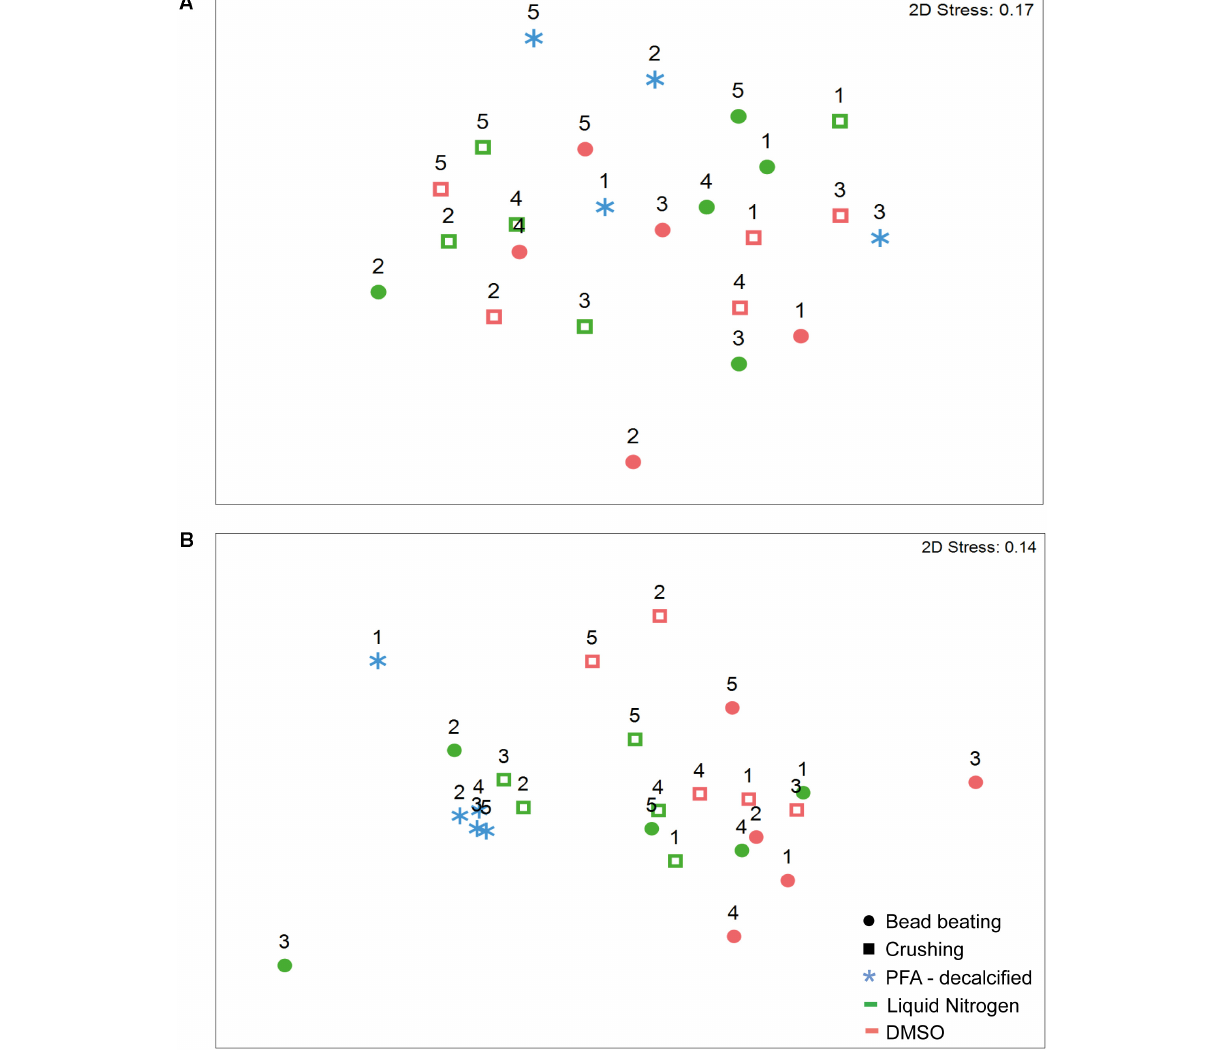
FIGURE 3 | nMDS ordination of bacterial assemblages’ relative abundance in G. edwardsi (A) and I. palifera (B). Bacterial communities are similar regardless of the preservation and homogenization method used in G. edwardsi bacterial assemblages (A) . I. palifera (B) bacterial assemblages treated with PFA-decalcified differ from the other methods. nMDS based on Bray–Curtis dissimilarity of relative abundance data (fourth root transformed). Colonies indicated with numbers. For presence/absence equivalent results see Supplementary Figure 2 and Supplementary Tables 6 , 8 , 10 , 12